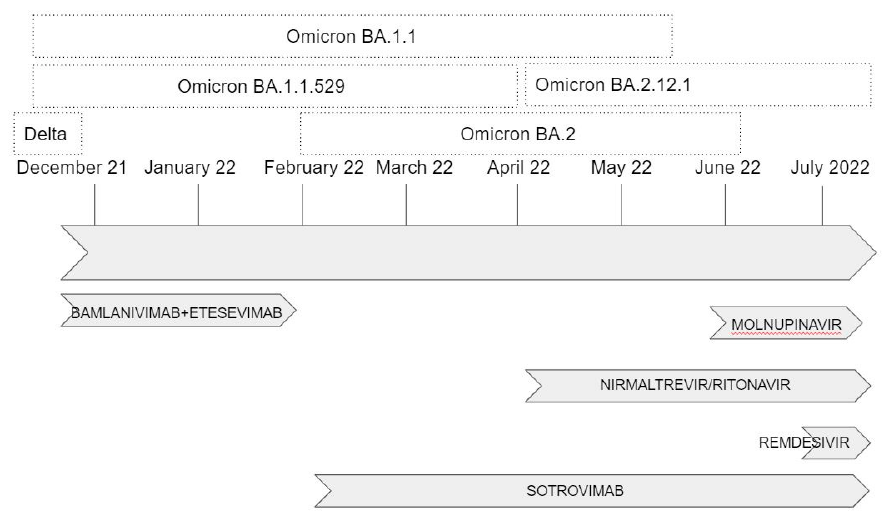
Figure 2. Timeline of variants/subvariants and administration of specific drugs over the study pe- riod.